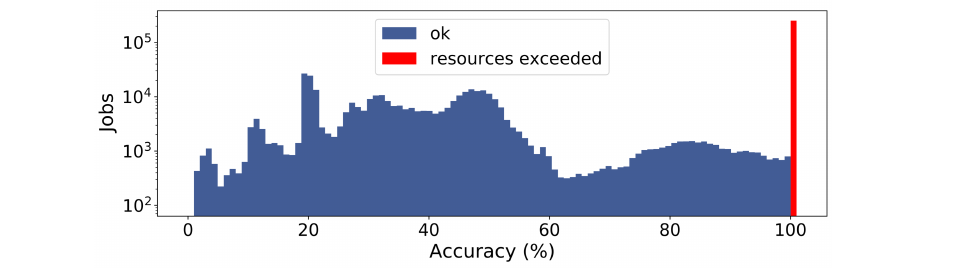
Figure 1. Accuracy of requested memory requirements to actual memory usage for end-user